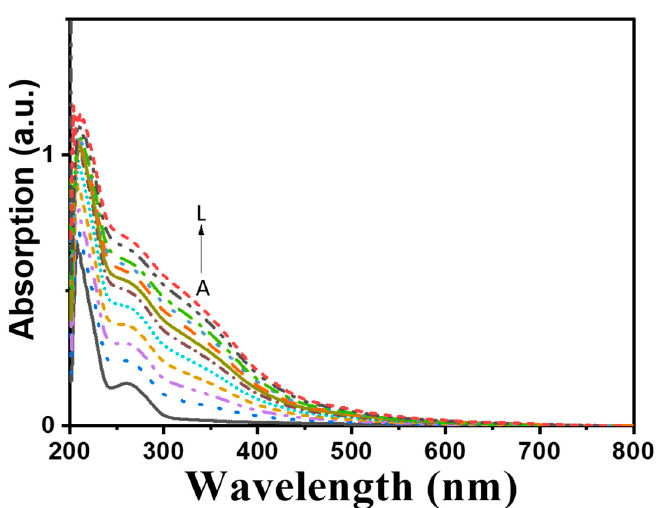
Figure 7. UV/visible absorption spectra of pure Melac13220 (0.6 U/mg) from in 20 mM Tris-HCl buffer (pH 7.5). The dotted lines show increasing Fe 2+ concentrations from bottom to top (A–L, from 0.012 mM to 0.112 mM).